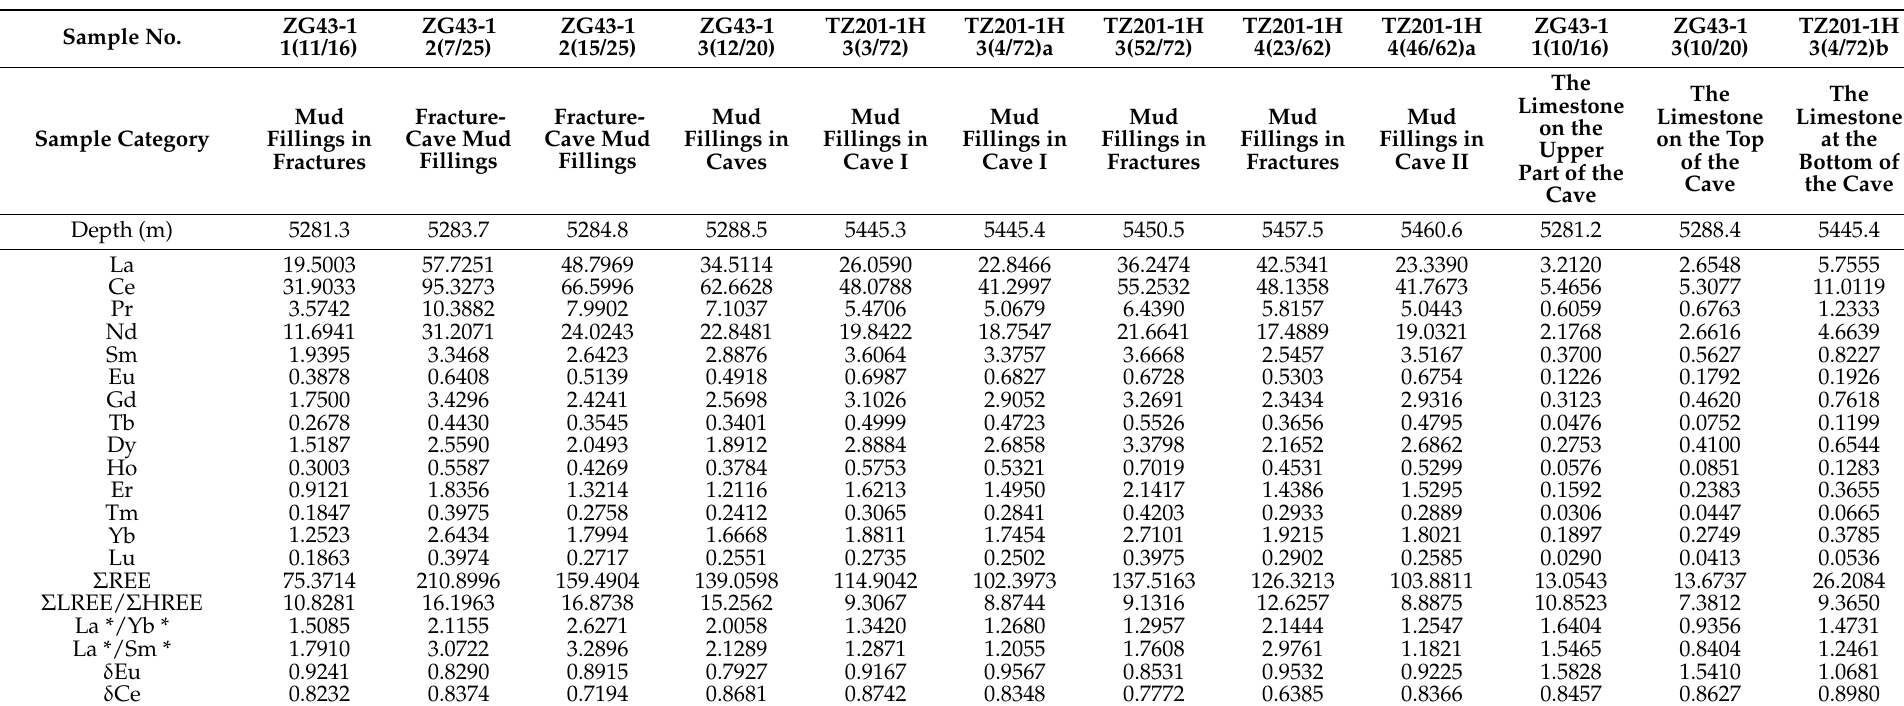
Table 3. Results of rare earth elements in mud fillings and nearby limestone of Yingshan Formation in the northern slope of Tazhong (ppm). Sample